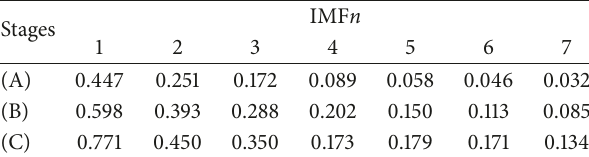
Table 3: Results of ApEn of the proposed